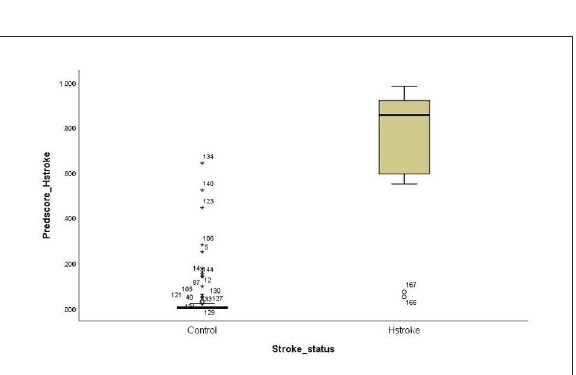
FIGURE5 Box plot for the probability of haemorrhagic